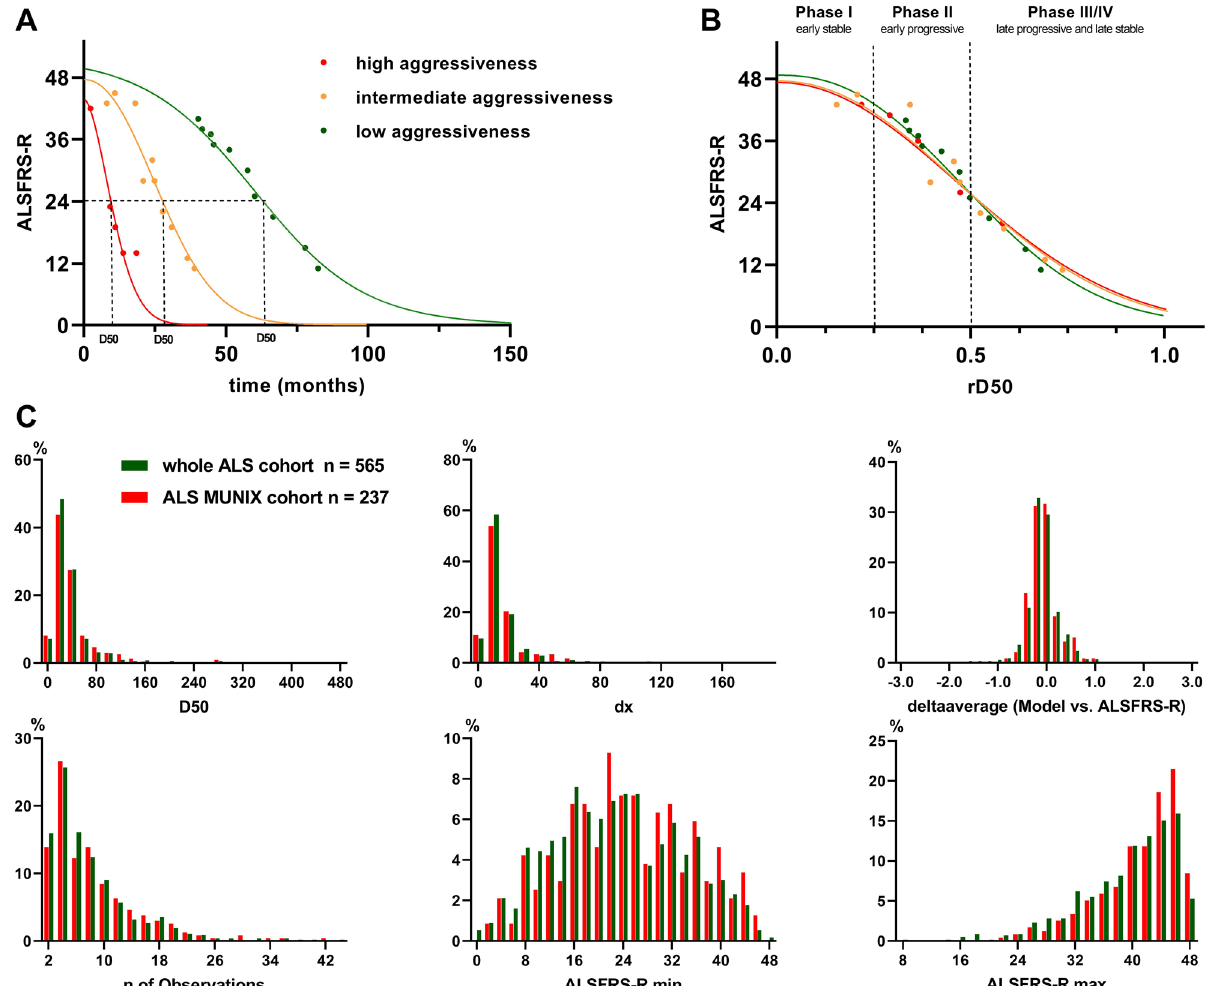
Figure 1. Principles and parameters of the D50 disease progression model: ( A ) calculated sigmoidal curves based on obtained ALSFRS-R scores (dots). D50 represents the individual time cape in months from symptom onset to halved functionality. Three example patients with high (red curve, D50 = 8.92 months), intermediate (yellow curve, D50 = 26.43 months) and low (green curve, D50 = 60.13 months) disease aggressiveness. ( B ) The individual disease duration in reference to D50 yields the parameter relative D50 (rD50). Patients with different D50 values go through similar phases (I–IV) of disease accumulation. rD50 allows to compare patients with vastly different disease aggressiveness. ( C ) Histograms of D50 model parameters of the ALS MUNIX cohort (n = 237, red bars) and of the whole ALS cohort (n = 565, green bars) available at our